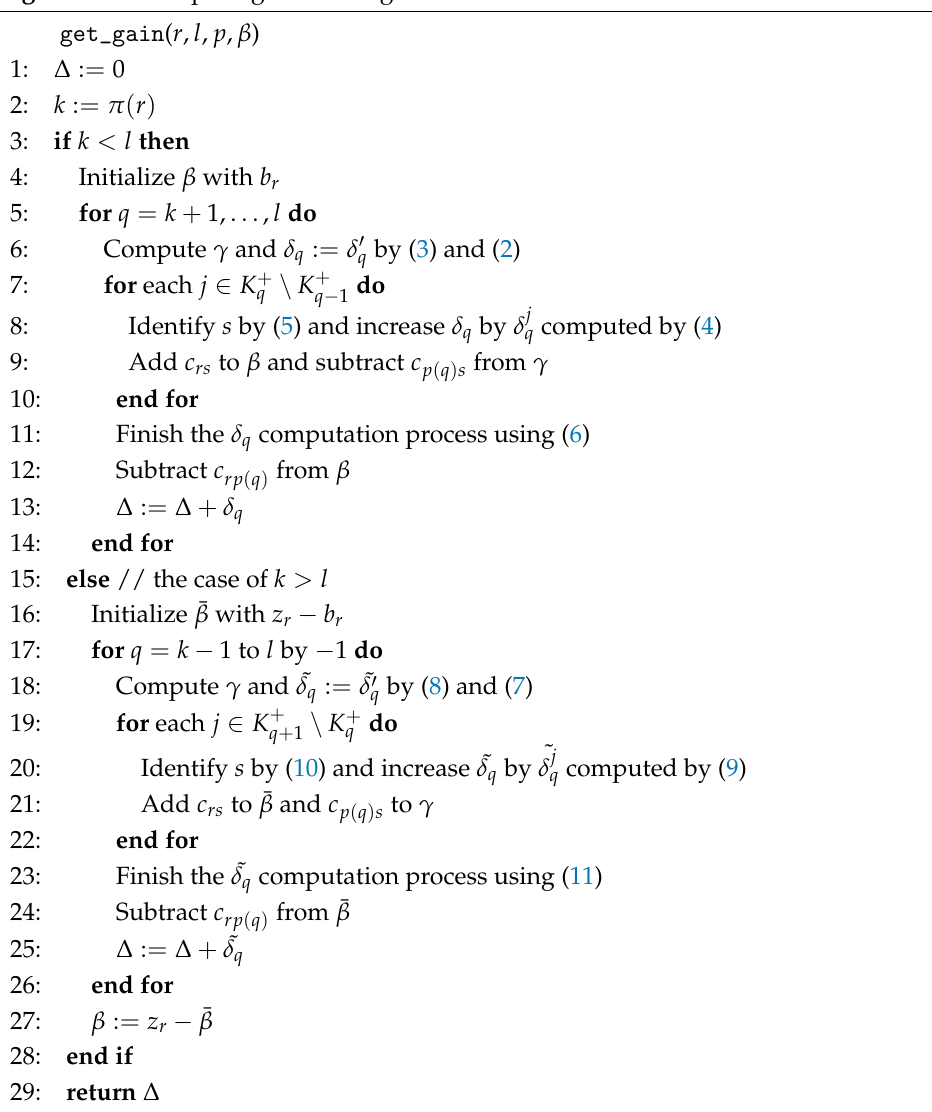
Algorithm 3 Computing the move